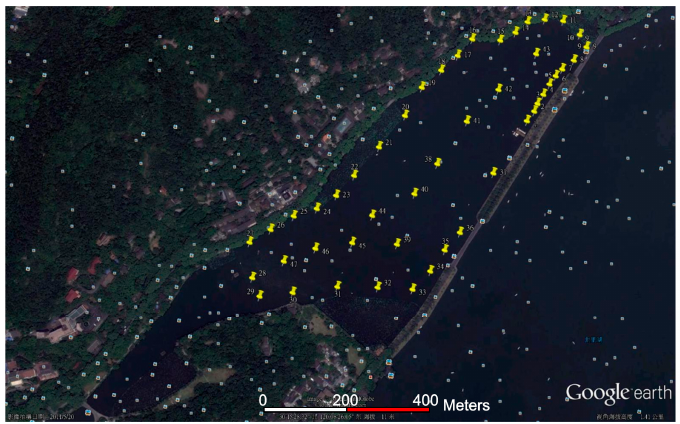
Figure 3. Locations of the field observations.